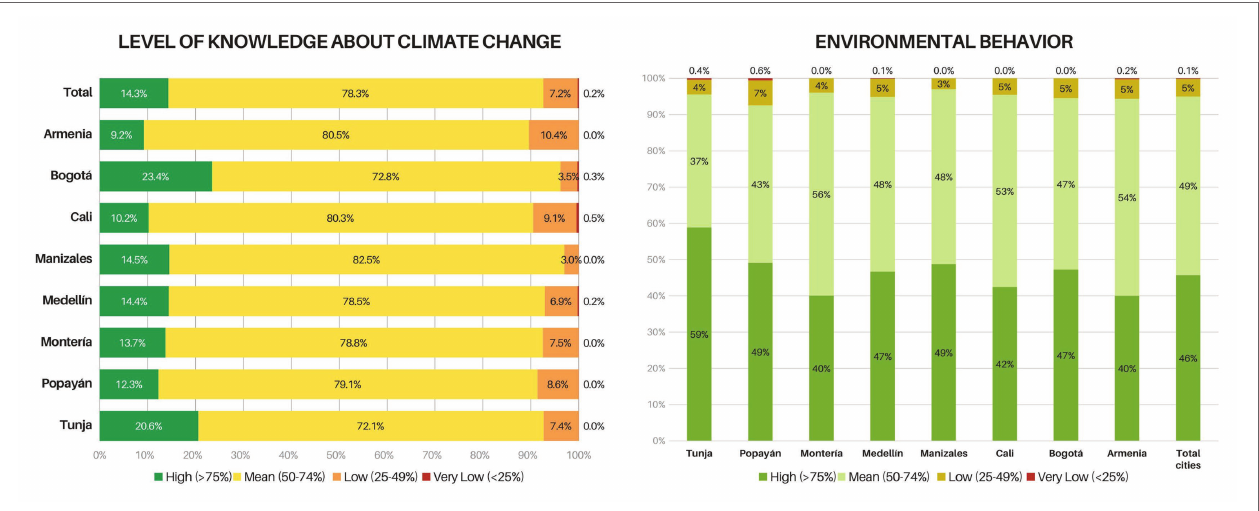
FIGURE 3 | Knowledge about climate change (left) and pro-environmental behaviors (right) by cities in